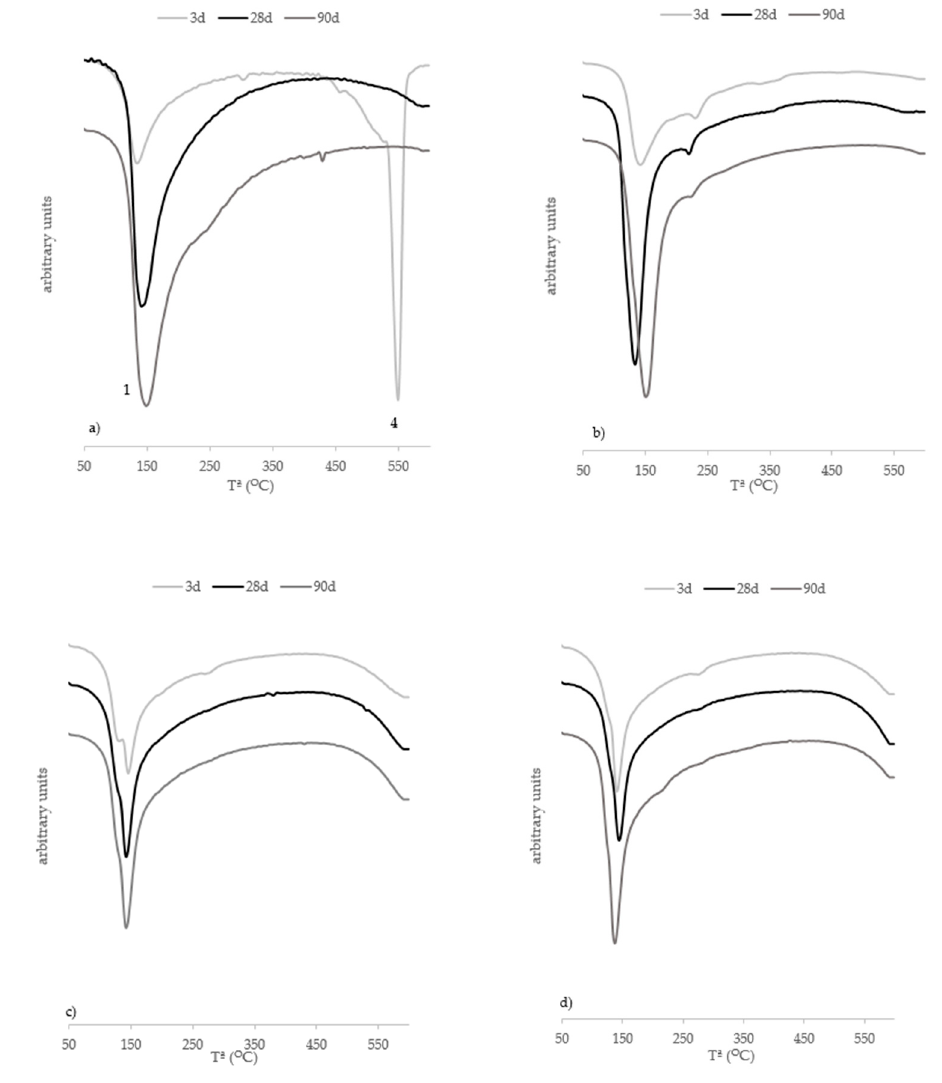
Figure 11. DTG curves of pastes at 3, 28 and 90 curing days: ( a ) T-RHA; ( b ) H-RHA/C; ( c ) H- RHA/RHA; ( d )